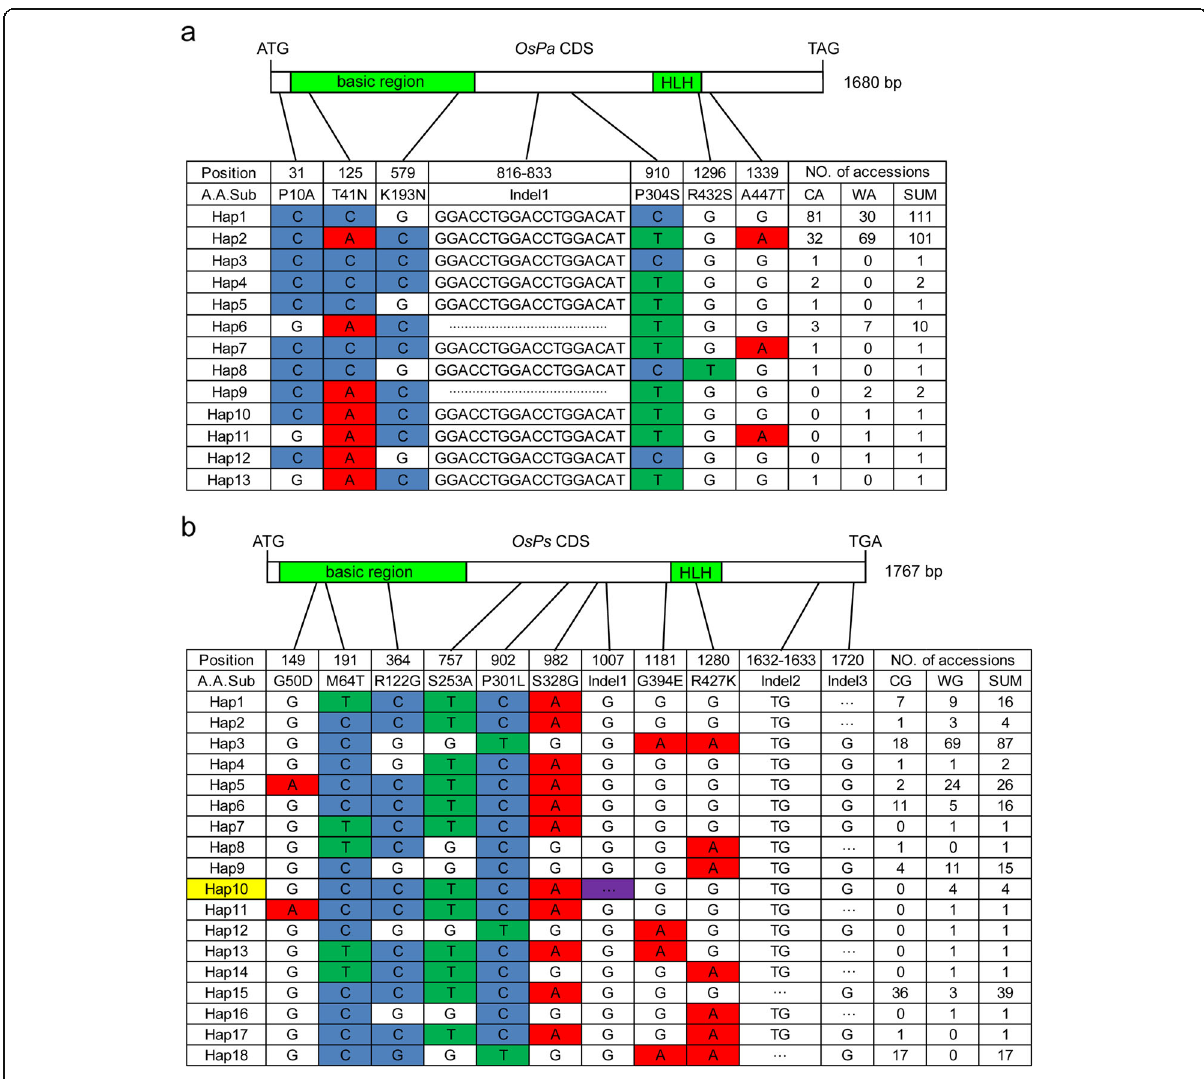
Fig. 7 Haplotype analysis of OsPa and OsPs in a nature rice panel. Haplotype analysis of OsPa ( a ) and OsPs ( b ) in 234 rice accessions. A.A.Sub are amino acid substitutions. CA, colored apiculi; WA, straw-white apiculi; CG, colored stigmas; WG, straw-white stigmas. Deletion and insertion sites are indicated by dashed lines. Haplotype analysis of OsPa and OsPs was carried out with reference to the sequences of Nipponbare (Hap1). A non-functional haplotype is indicated in yellow. Polymorphic nucleotides causing loss-of-function are in purple. The number of accessions for each haplotype is shown in the right